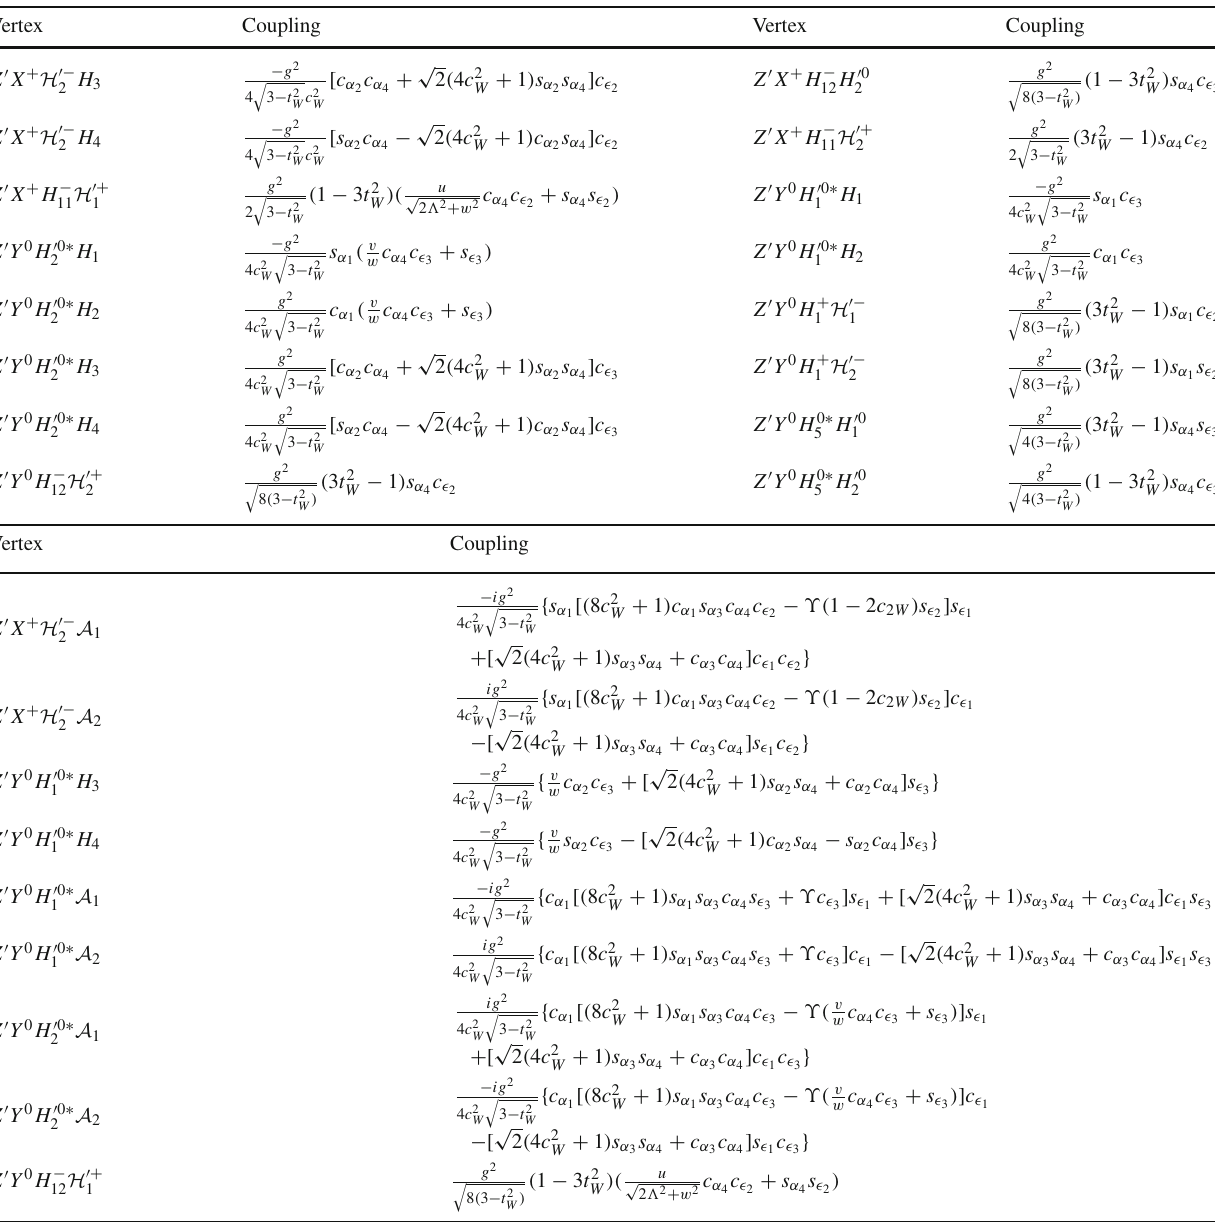
Table 8 The interactions of a neutral and a charged gauge boson with two scalars